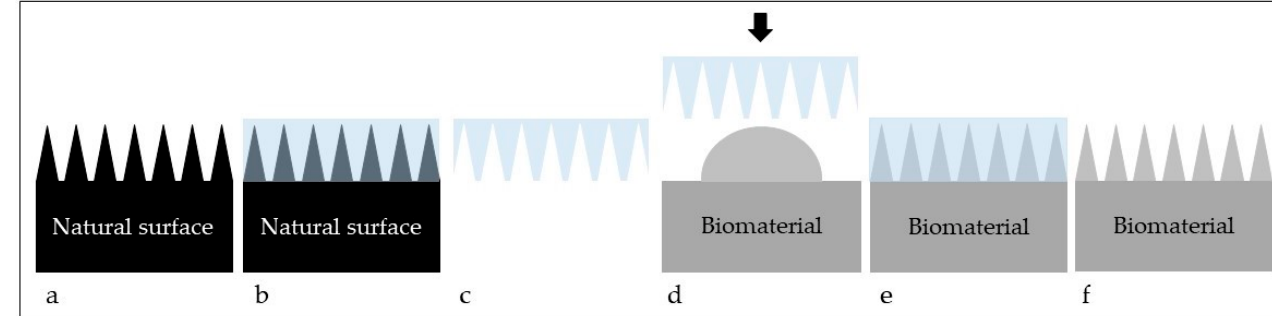
Figure 1. Schematics of the soft lithography process. A natural surface ( a ) is selected and its topography is duplicated using PDMS ( b ). The PDMS stamp that contains the negative impression of the topography is obtained ( c ). The PDMS stamp is used to transfer such topography to another surface (biomaterial) using different compounds, (i.e., silica, titanium dioxide, etc.) ( d ) and such compound is allowed to cure ( e ). Once the transferring process is complete, the PDMS stamp is removed and the topography from the natural surface will remain on the biomaterial’s surface ( f ).